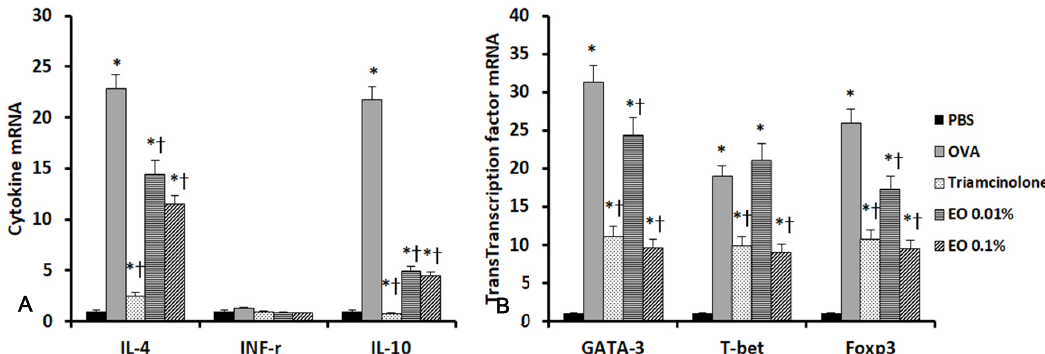
Figure 3. E ff ects of essential oil from Chamaecyparis obtusa (EOCO) on the expression of inflammatory mediator ( A ) and transcription factor mRNAs ( B ) in the sinonasal mucosa (n = 4 mice per group).